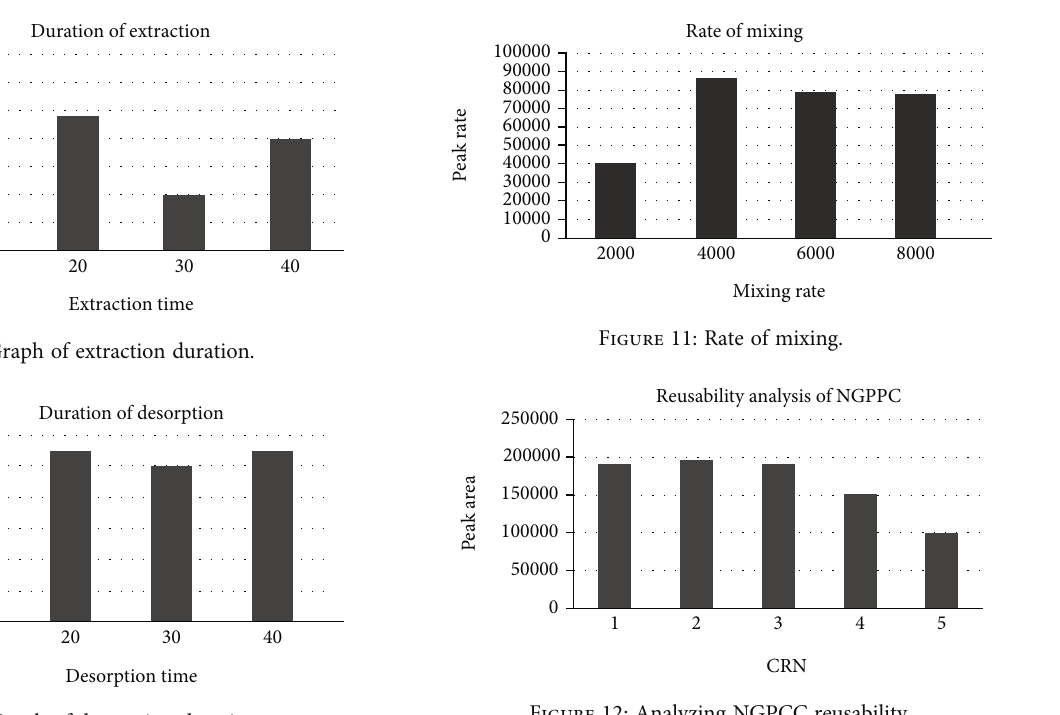
Figure 10: Graph of desorption duration.